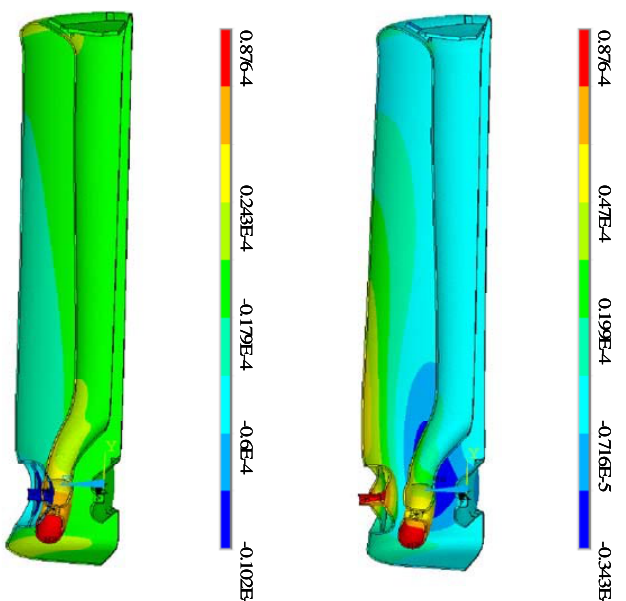
FIG. 11. (Color) ANSYS results of the cavity deformations in the Z direction along the beam line due to the helium pressure (left) and the combined effect of the helium pressure and mechanical of the cavity is shown. tuner with pulling force (right). Only 1 4